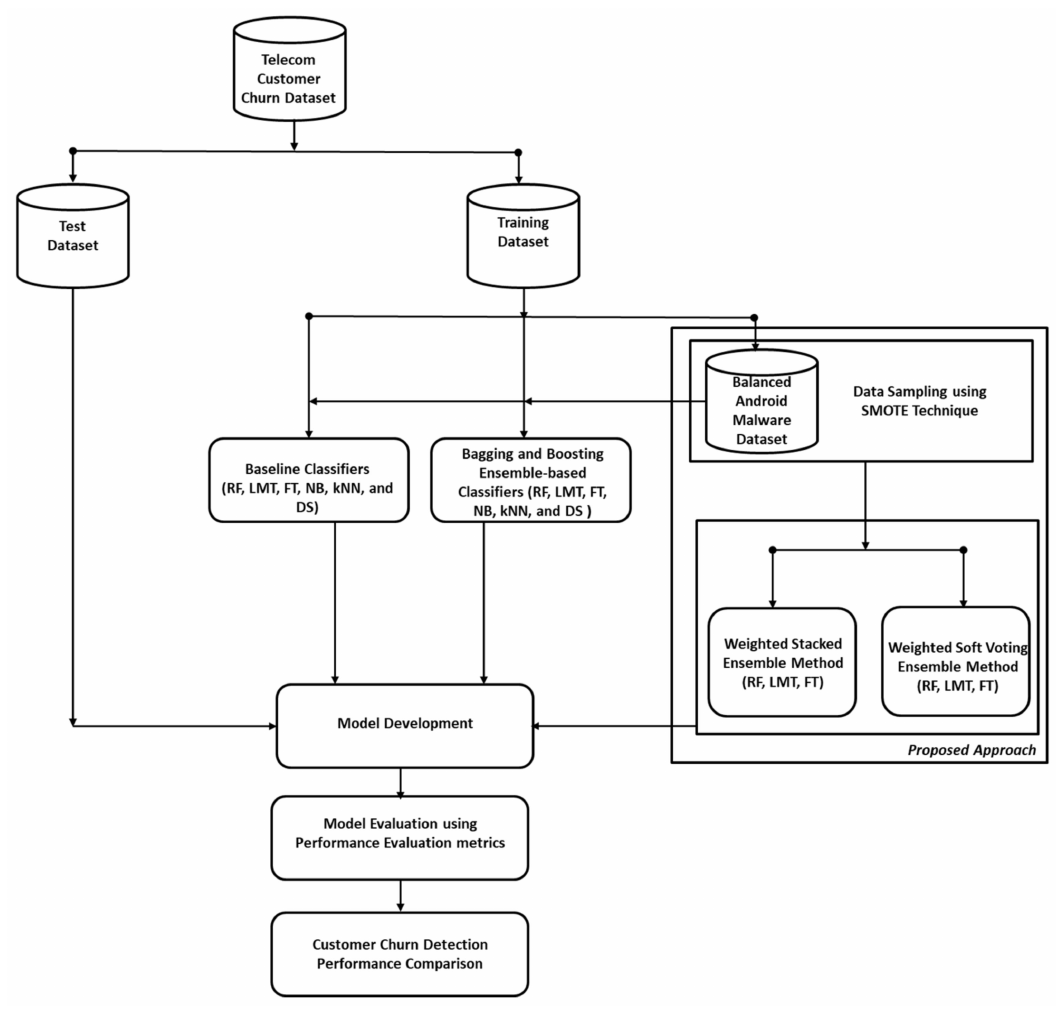
Figure 1. Experimental